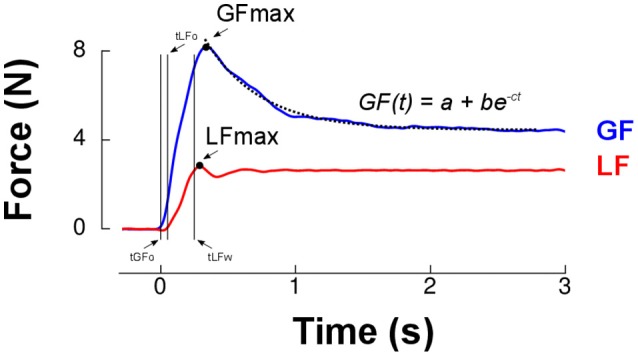
Grip force (blue trace) and load force (red trace) over time for a single lift trial. The first two vertical cursors (tGFo and tLFo) enclose the preload phase. Time 0 ms corresponds to grip force onset (tGFo). The loading phase is the time between tLFo and tLFw (two last vertical cursors, see Methods). The dashed line is the best exponential fit to grip force between its peak (GFmax, black dot) and the end of the trial. Parameter a provides a more reliable estimate of grip force reached in the plateau phase than a classical average during the last portion of the trial. The rate of decrease of grip force following its maximum was quantified by parameter c.